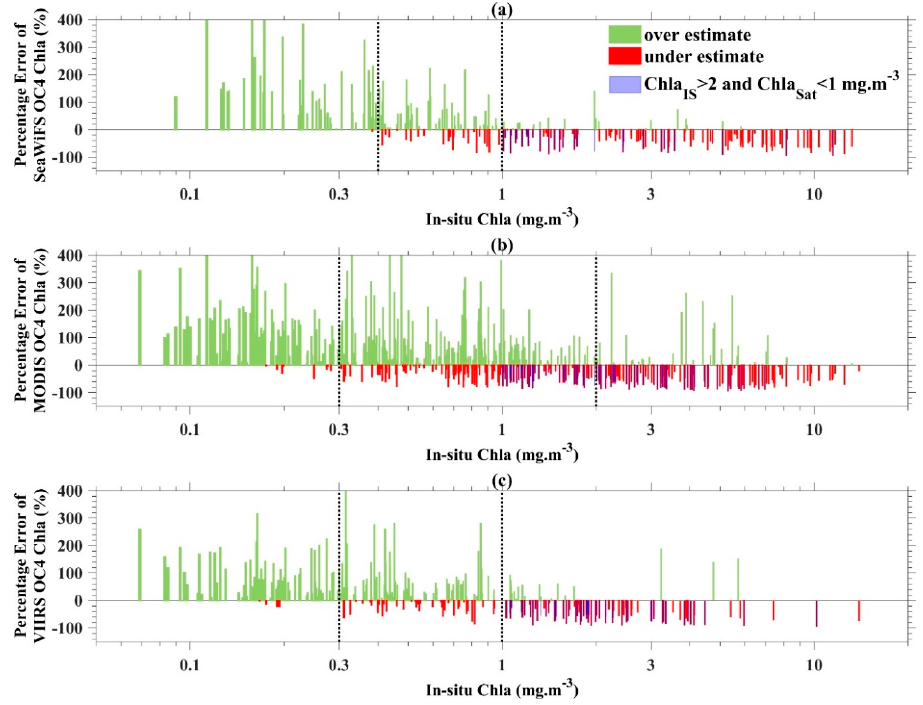
Figure 7. Histograms of percentage error of ( a ) SeaWiFS, ( b ) MODIS, ( c ) VIIRS OCx Chla products, compared to in situ measured Chl a .